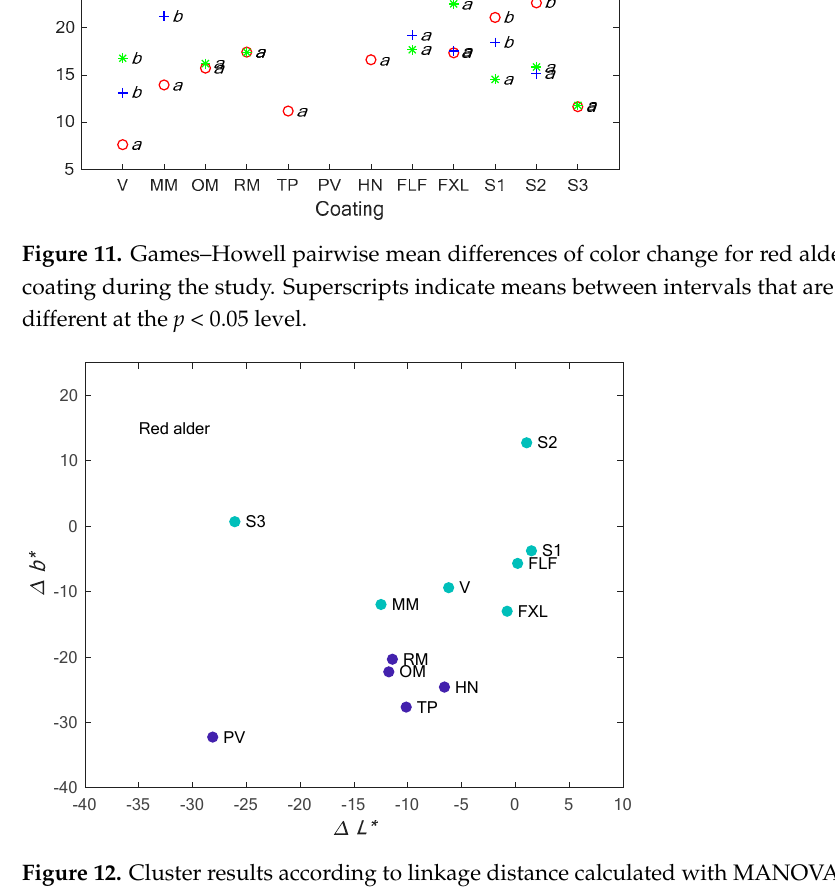
Figure 11. Games–Howell pairwise mean differences of color change for red alder wood for each coating during the study. Superscripts indicate means between intervals that are not significantly different at the p < 0.05 level.